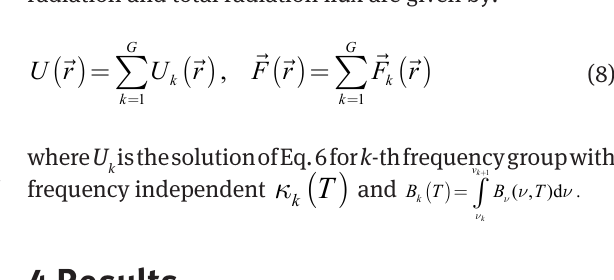
+ 10% Cu at the pressure 0.5 6